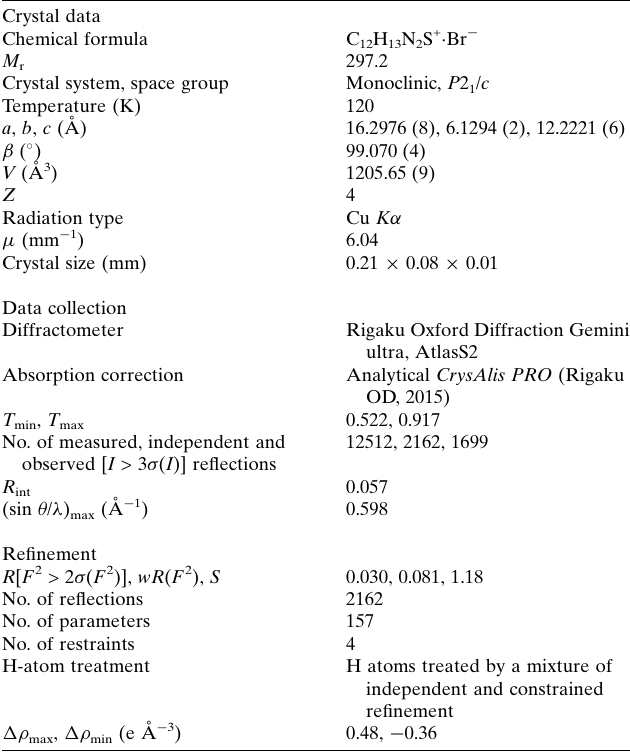
Table 2 Experimental details. Crystal data Chemical